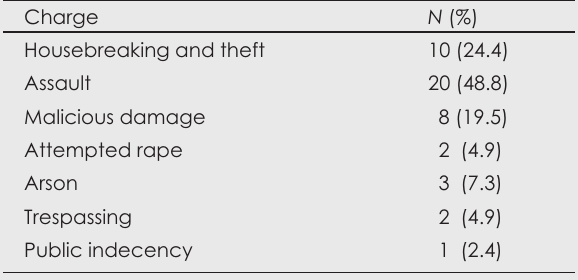
Table I. Charges against judicial section 9 patients ( N = 46) Charge N (%) Housebreaking and theft